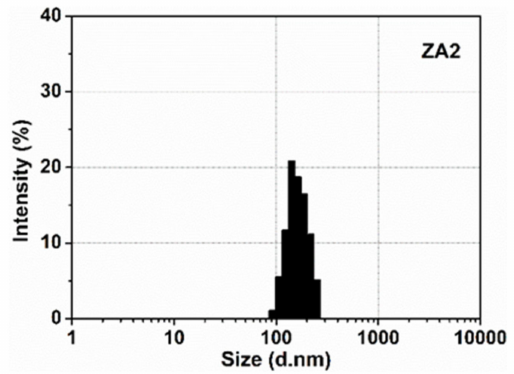
Figure 12. The particle size distribution of ZA2 composite-hardened sol.